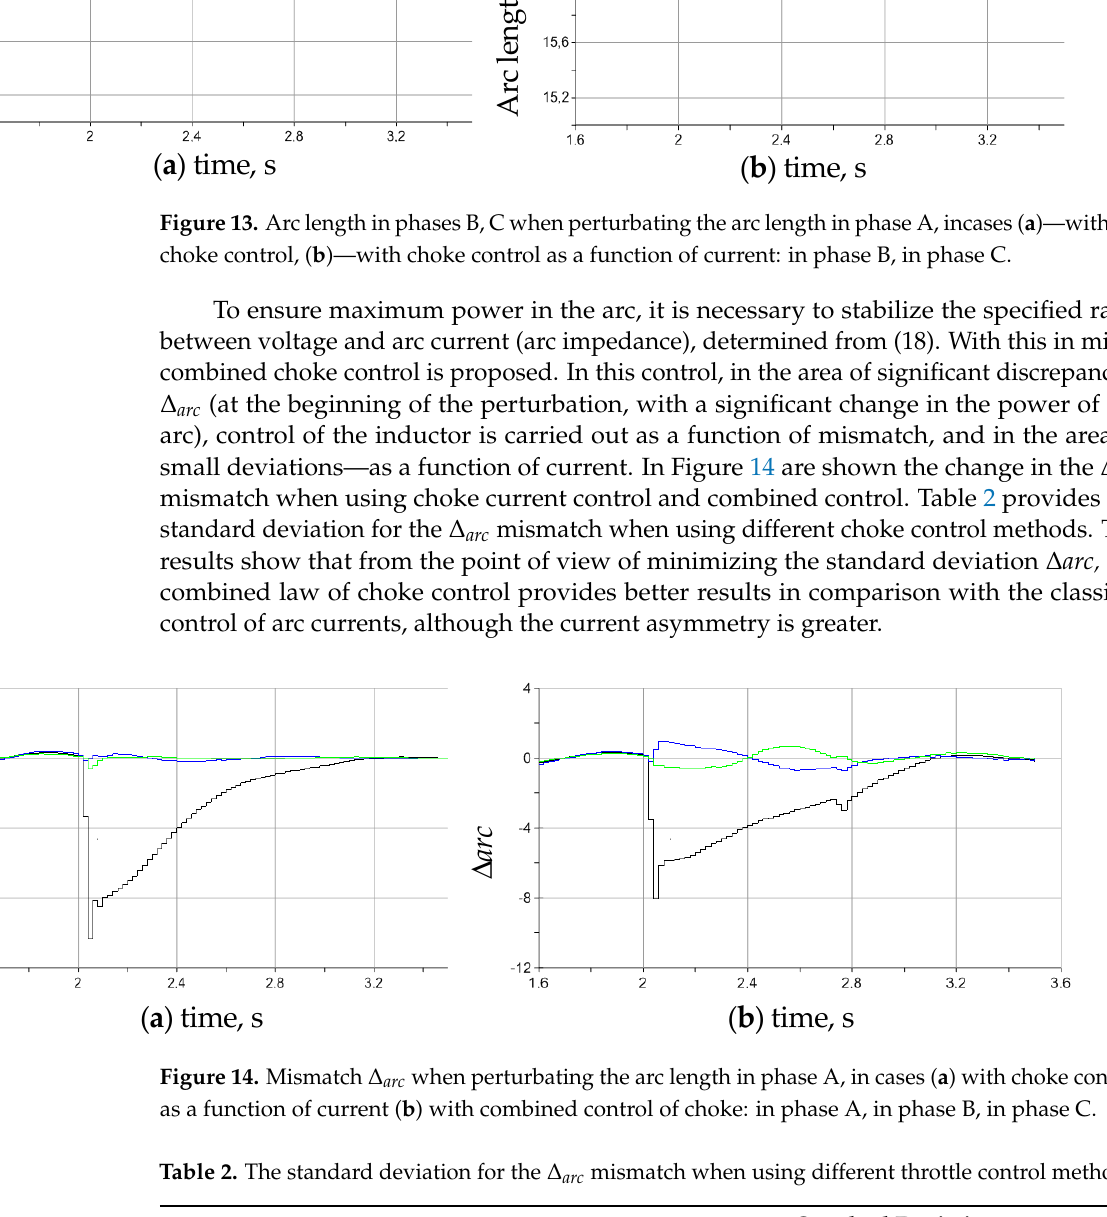
Figure 12. Arc length in phase A, B, C when perturbating the arc length in phase A, incases ( a )— without choke control, ( b )—with choke control as a function of current: in phase A, in phase B, in phase C.